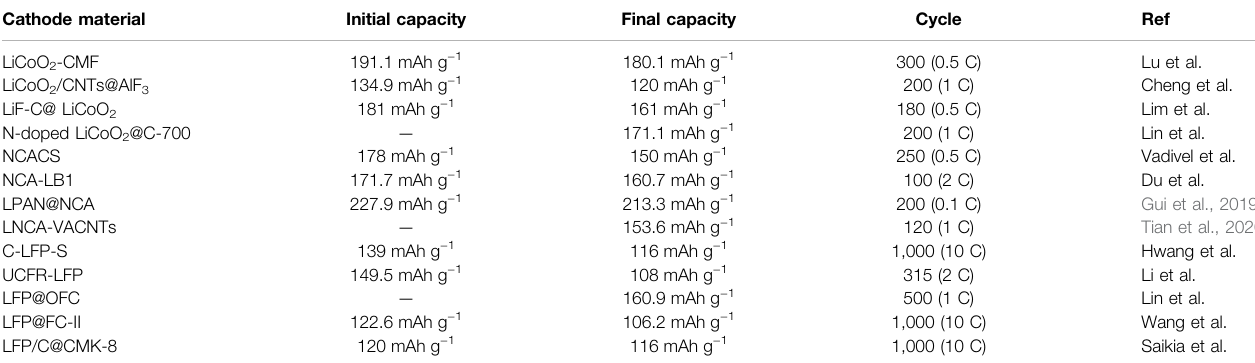
TABLE 1 | Electrochemical performance of carbon-based materials that modi fi ed cathodes. Cathode